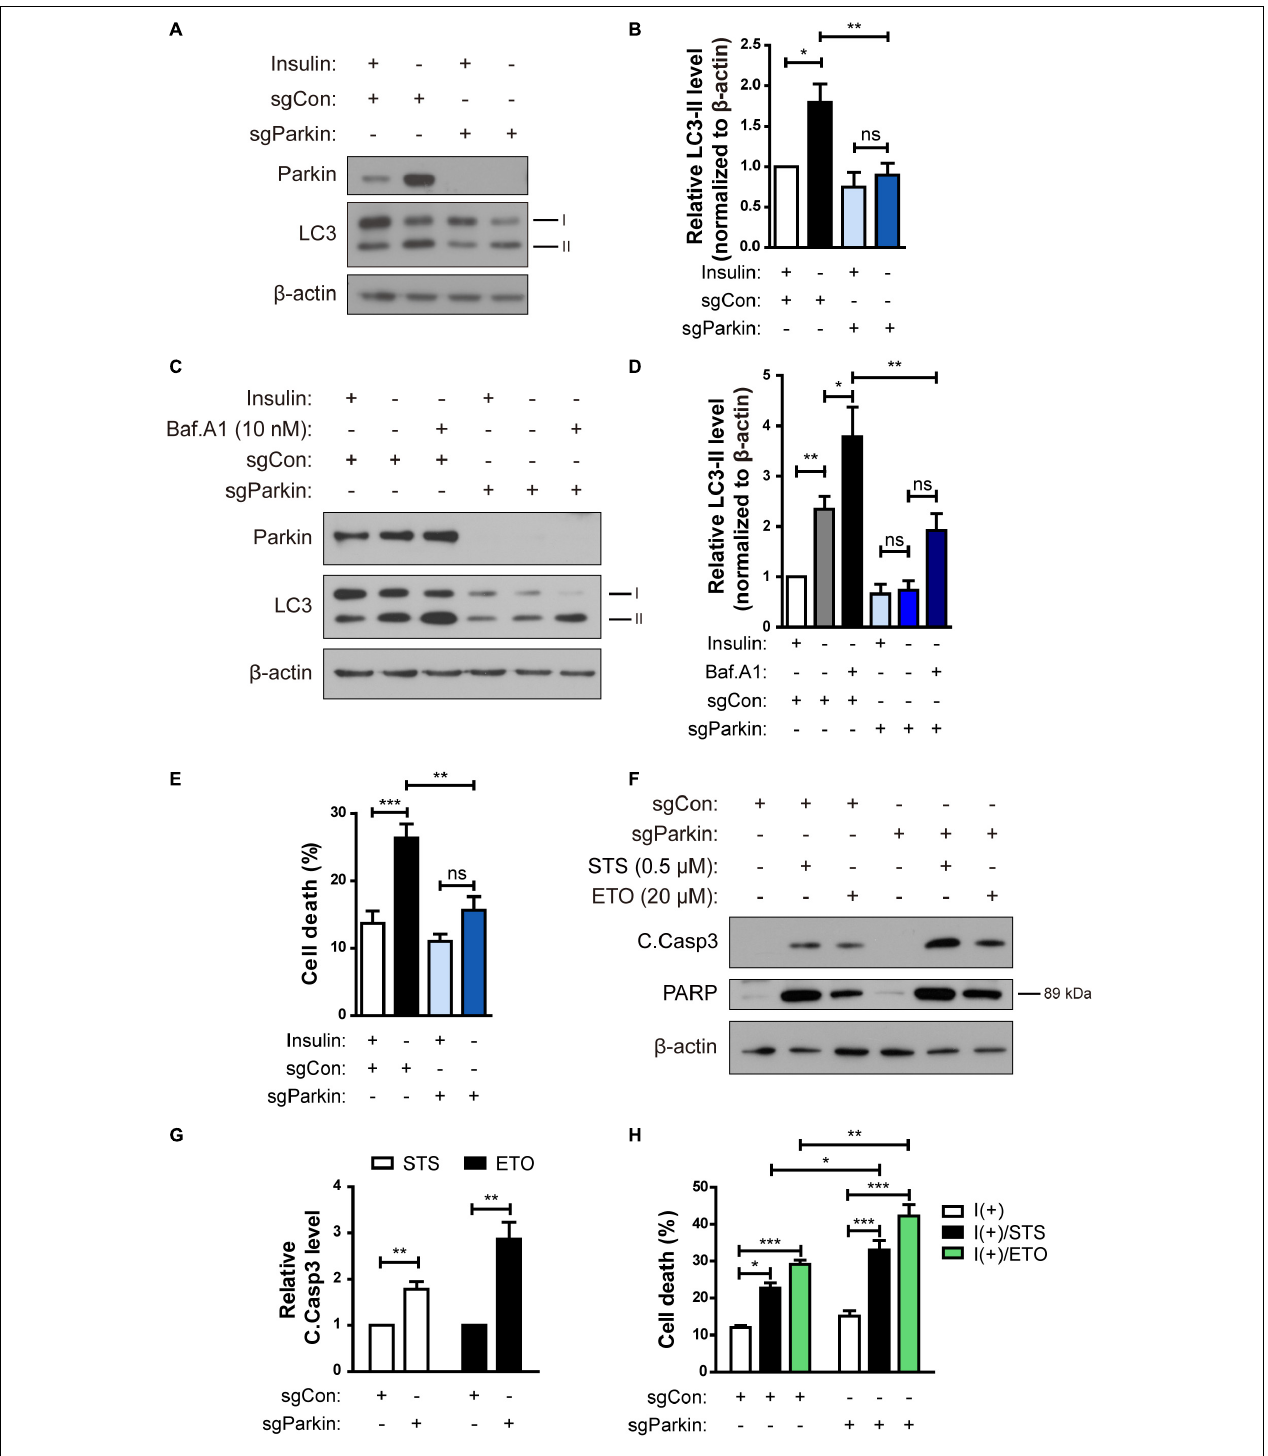
FIGURE 6 | Parkin knockout (KO) prevents ADCD in HCN cells following insulin withdrawal. (A) A decrease in autophagy level in sgParkin cells after insulin withdrawal for 24 h. (B) Quantification of LC3-II levels ( n = 6). (C) Autophagic flux in sgParkin cells after insulin withdrawal. Cells were treated with Baf.A1 (10 nM) before harvesting. The blots shown are representative of four experiments with similar results. (D) Quantification of LC3-II levels ( n = 4) from (C) . (E) Cell death rates in sgCon and sgParkin cells after insulin withdrawal for 24 h ( n = 11). (F) Western blotting analysis of C.Casp3, PARP after STS (0.5 µ M) or etoposide (ETO) (20 µ M) treatment for 8 h. (G) Quantification of C.Casp3 level after normalization to β -actin ( n = 5–7). (H) Cell death rates of sgCon and sgParkin cells after STS or ETO treatment for 8 h ( n = 3). ∗ p < 0.05, ∗∗ p < 0.01, ∗∗∗ p < 0.001.